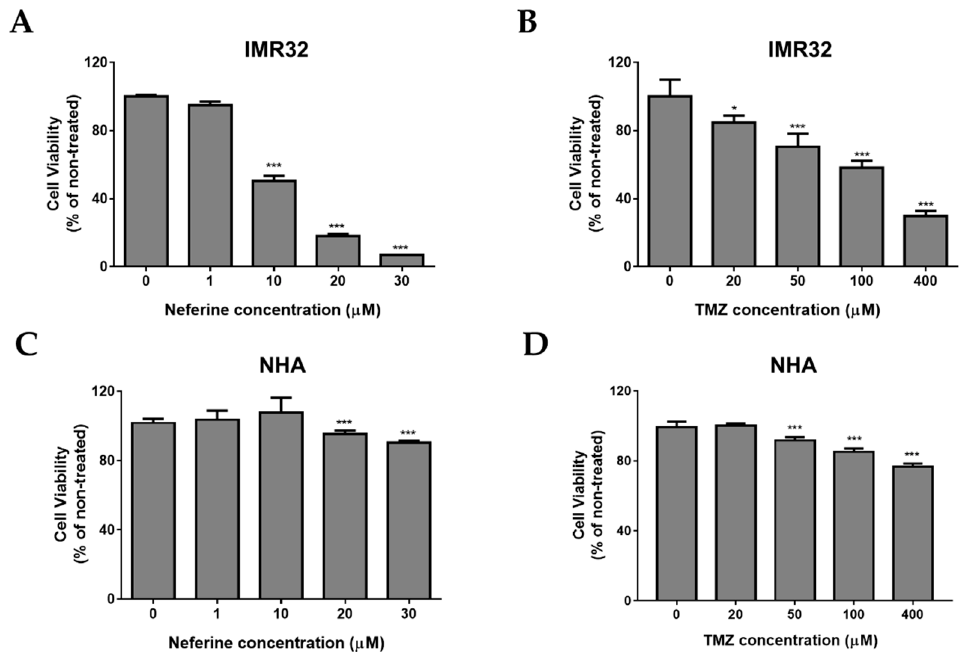
Figure 1. Neferine suppresses cell proliferation in human neuroblastoma cells. (A,B) IMR32 cells were treated with 1, 10, 20, and 30 μ M of neferine or 20, 50, 100, and 400 μ M of TMZ for 24 h. (C,D) Normal human astrocytes (NHA) were exposed to the indicated doses of neferine and TMZ for 24 h. Cell viability was analyzed by MTT assay, and the surviving cells were determined and presented as a percentage of the non ‐ treated cells. Data are presented as mean ± standard deviation (SD) in three independent experiments. * p < 0.05, *** p < 0.001 as compared with the non ‐ treated control.